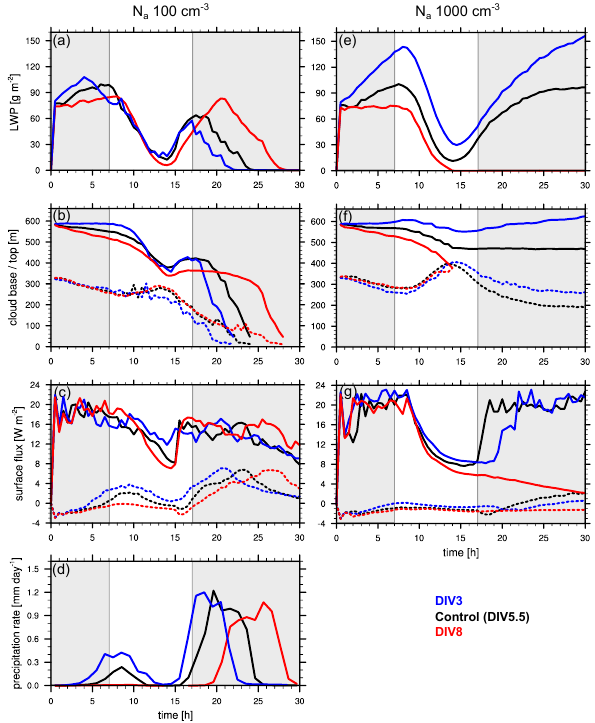
Fig. 8. The same as Fig. 6, except for Control (black), QFT3 (blue) and QFT1 (red) case.